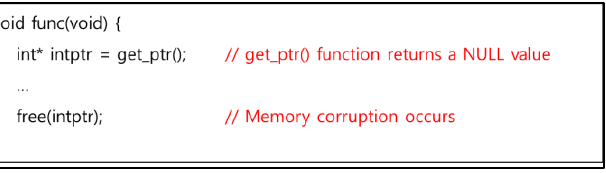
Figure 2. Example of memory corruption due to NULL pointer deallocation.